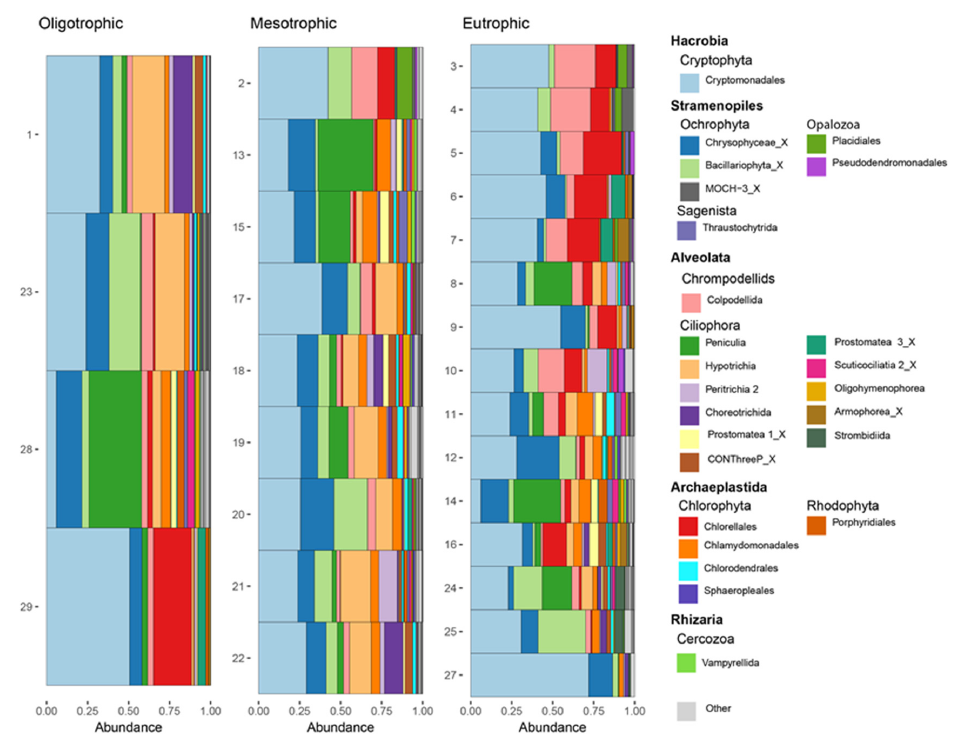
Figure 4. Relative abundance of protists, at the order level, within sampling sites, during 5–10 October 2019, along the New River, Belize based on impacted status from October 2019. The 25 most abundant protistan groups are included.